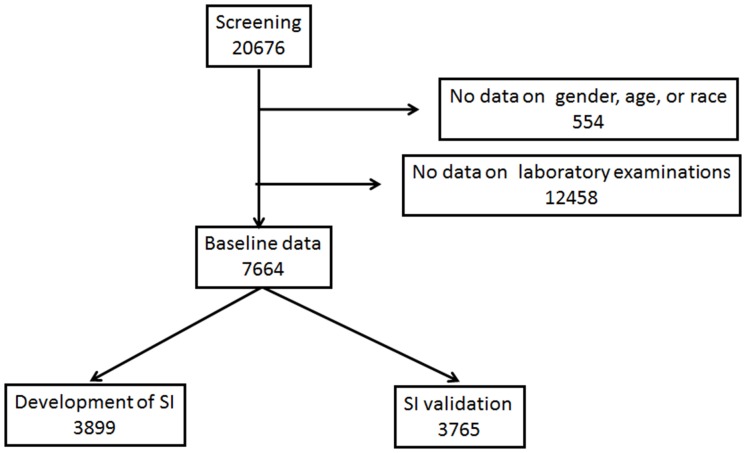
Flow diagram of participants.Abbreviation: SI, survival index.